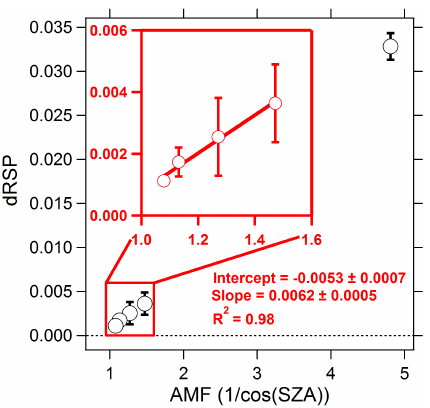
Figure 6. Direct sun dRSP as a function of the air mass fac- tor, AMF = 1 / cos ( SZA ) . All direct sun spectra measured on 22 July 2012 were evaluated (SZA binned) relative to a direct sun reference spectrum measured at SZA = 28 ◦ . The insert shows the magnification of the linear correlation plot used to quantitatively determine the offset at AMF = 0 (see text for